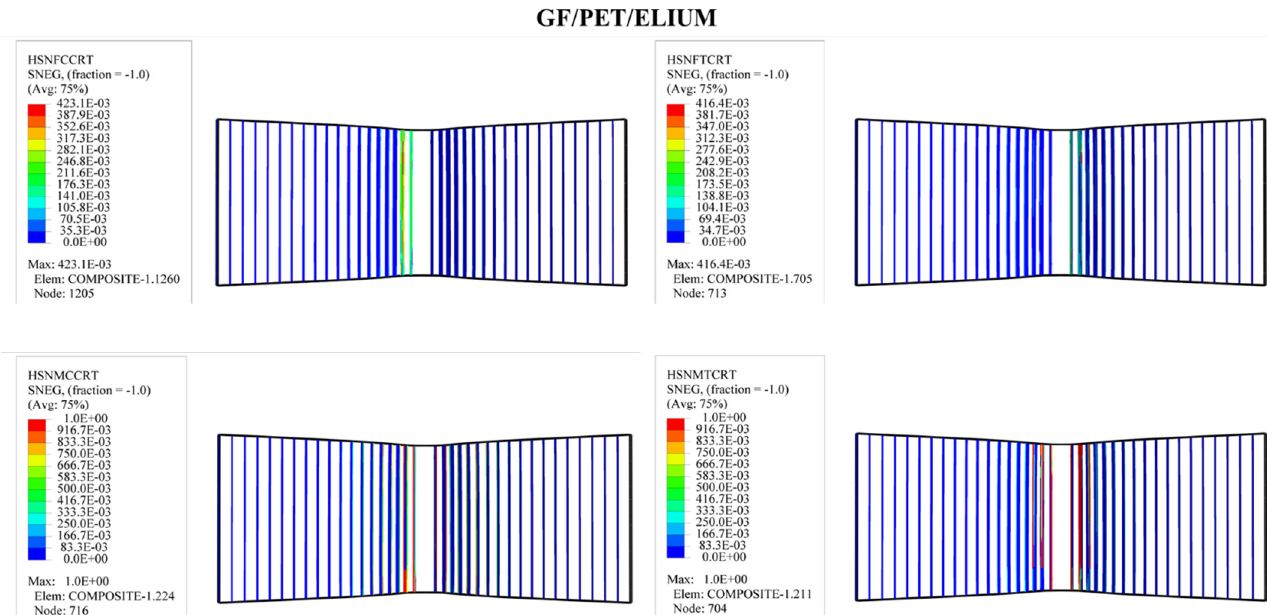
Figure 14. Numerical Hashin’s damage initiation of the upper skin of GF/PET/Elium sandwich composites.